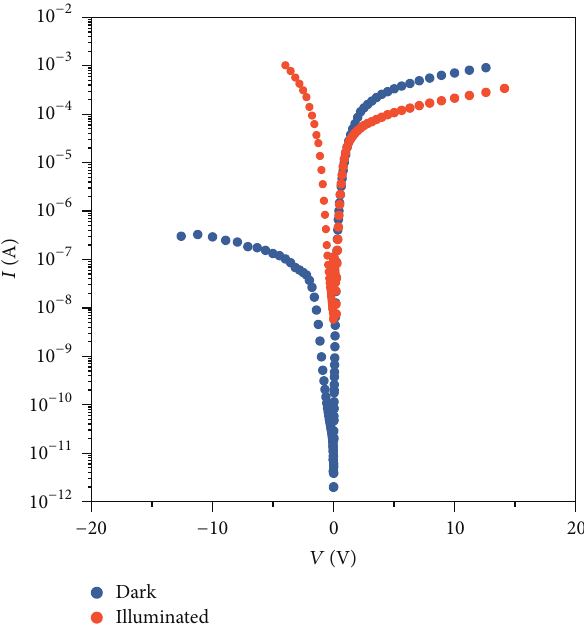
curve of Ag/TiO 2 /p-c-Si at 1MHz fre-